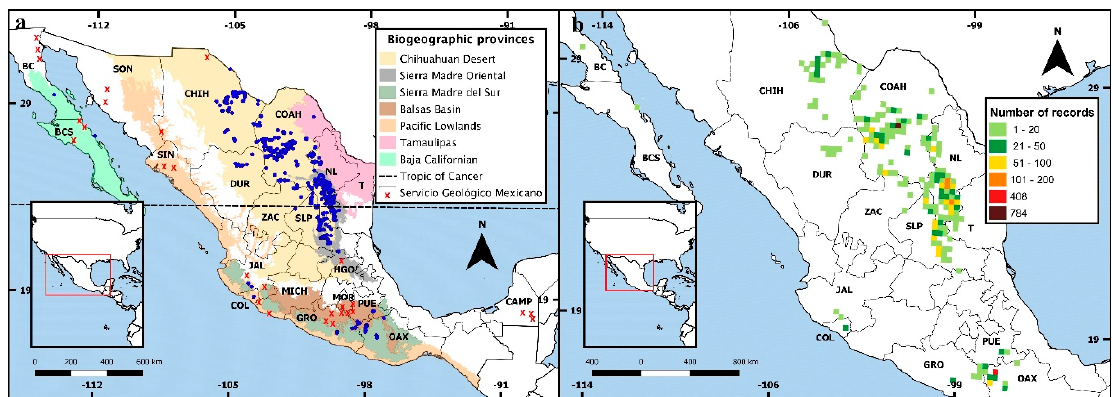
Figure 2. Current distribution of botanical collections on gypsum: ( a ) gypsisols with botanical records in Mexico and ( b ) number of observations in gypsum sites. The blue dots constitute all the botanical records. The red crosses represent gypsisol sites reported by the SGM [9] without botanical records. State abbreviations: BC = Baja California, BCS = Baja California Sur, CAMP = Campeche, COAH = Coahuila, COL = Colima, CHIH = Chihuahua, DUR = Durango, GRO = Guerrero, HGO = Hidalgo, JAL = Jalisco, MICH = Michoacán, MOR = Morelos, NL = Nuevo León, OAX = Oaxaca, PUE = Puebla, SIN = Sinaloa, SLP = San Luis Potosí, SON = Sonora, T = Tamaulipas, ZAC = Zacatecas.